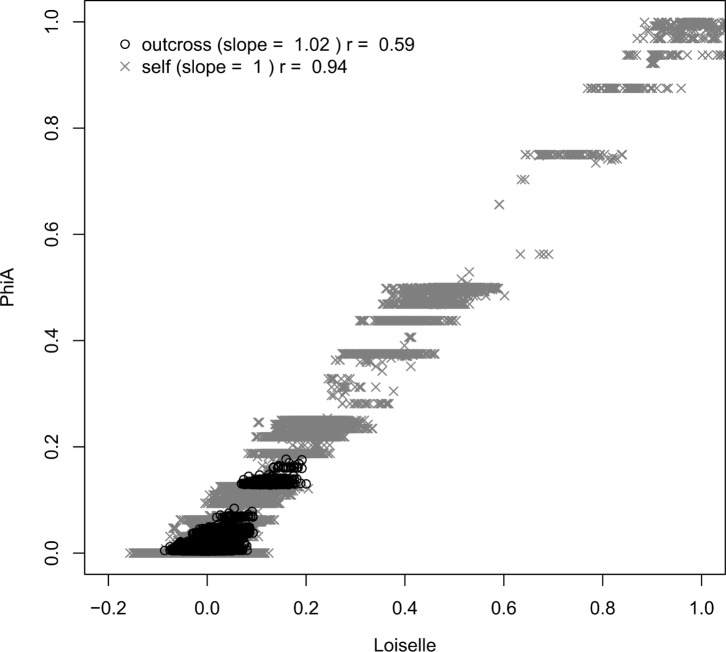
Higher mean and larger variance in pairwise relatedness coefficients in selfing compared to outcrossing populations.Regression between pairwise Loiselle coefficients estimated using 1500 SNP and ΦA. The population comprised 500 individuals with 90% selfing (grey crosses) or complete outcrossing (black circles). The legend indicates the slope of the regression of ΦA against Loiselle and the correlation coefficient r. The variance in relatedness was 0.0026 in the outcrossing population and 0.0108 in the selfing population (within the range of variances observed in wild populations, see Table 1 and [23]).